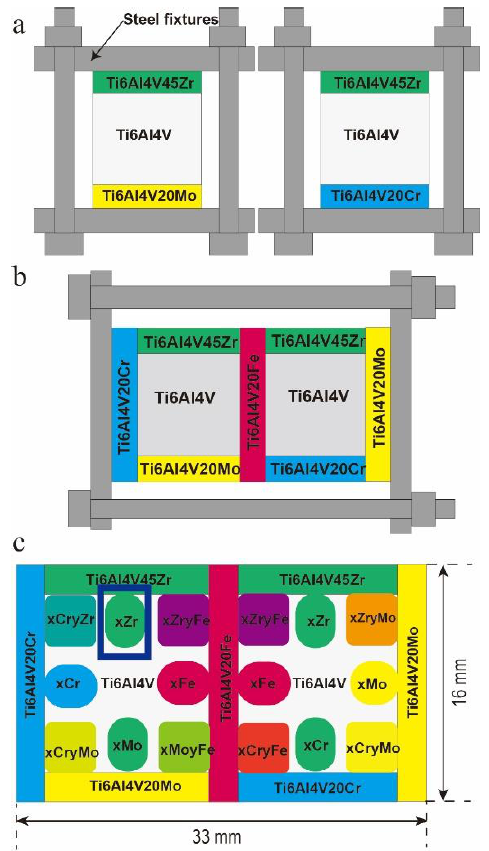
Figure 1. The fabrication process of Ti6Al4V-Ti6Al4V20Fe-Ti6Al4V20Cr-Ti6Al4V20Mo-Ti6Al4V45Zr diffusion multiple: ( a ) two diffusion multiples with three bricks of alloys were manufactured with steel fixtures; ( b ) Ti6Al4V-Ti6Al4V20Fe-Ti6Al4V20Cr-Ti6Al4V20Mo-Ti6Al4V45Zr diffusion multiple manufactured with steel fixtures; and ( c ) cross-sectional schematics of the Ti6Al4V-Ti6Al4V20Fe- Ti6Al4V20Cr-Ti6Al4V20Mo-Ti6Al4V45Zr diffusion multiples.